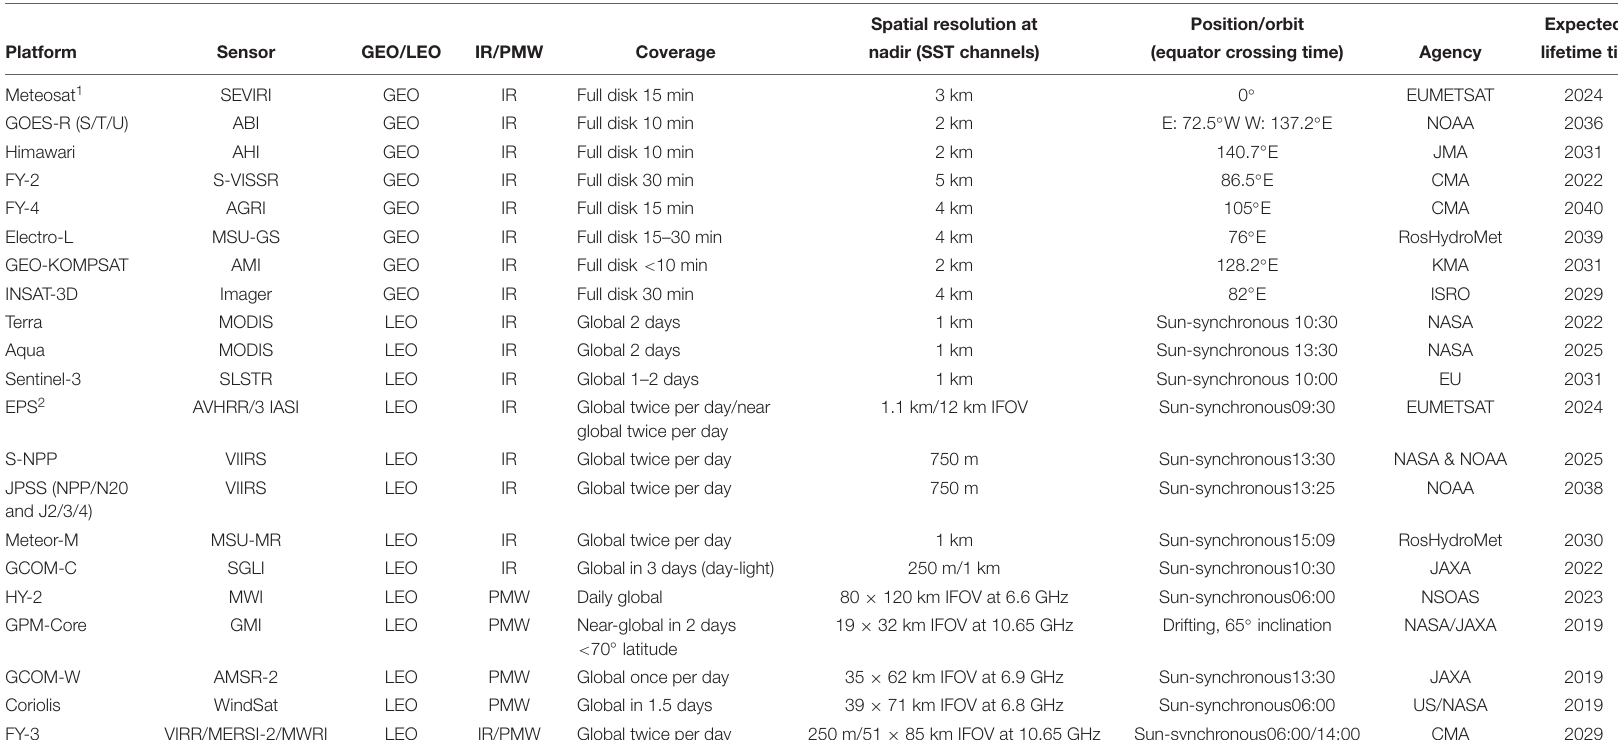
TABLE 1 | Current platform and sensor characteristics with capability for sea surface temperature, specifying whether in GEO or LEO; IR or PMW; daily coverage; spatial resolution at nadir; position or orbit and equator crossing time; agency and the expected lifetime